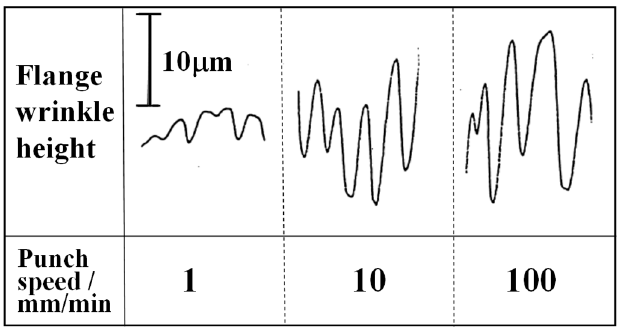
Figure 5. Effect of punch speed on the long wavelength wrinkle height on the flange end part under BHF = 0.1 kN and punch stroke = 20 mm (DR = 5.0).